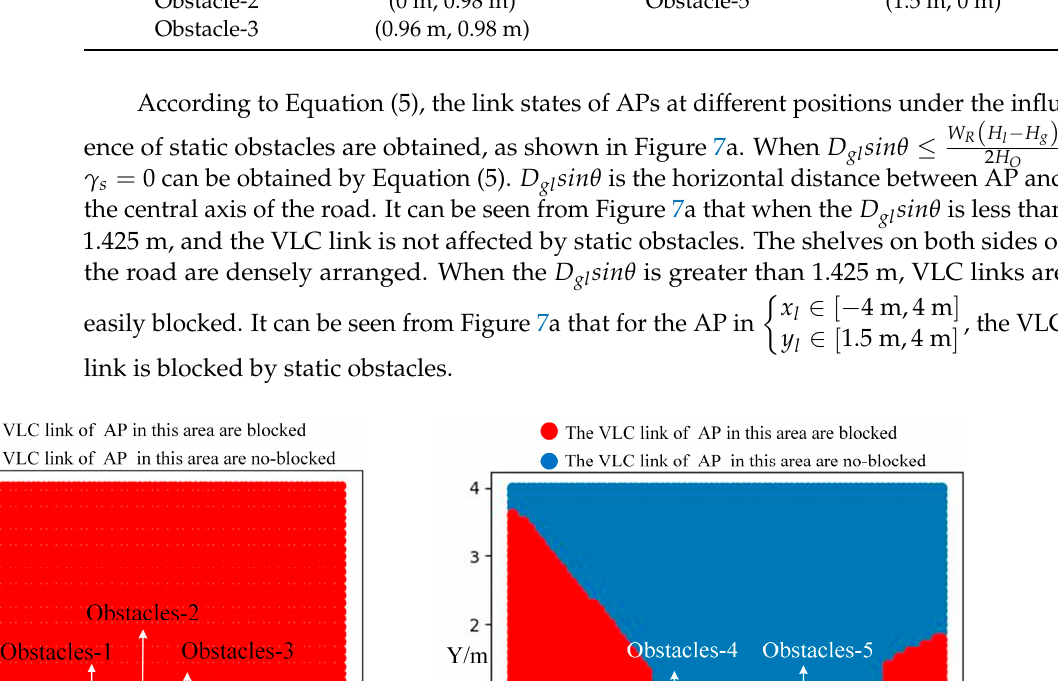
Table 2. Specific positions of obstacles.